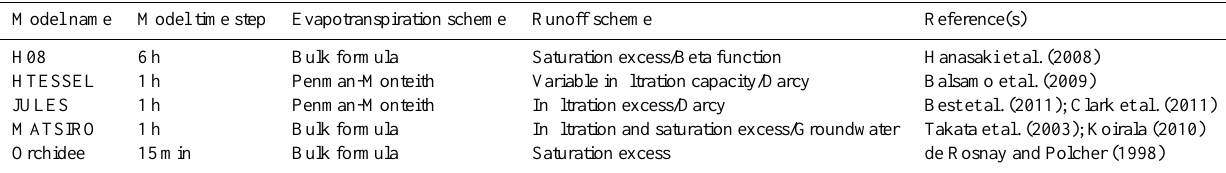
Table 1. Main characteristics of the LSMs (derived from Haddeland et al.,